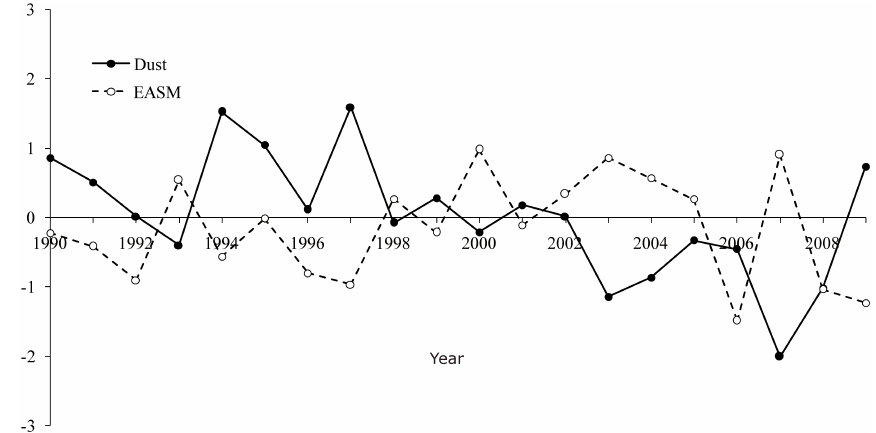
Figure 7. Difference of CON minus SEN in the normalized regional mean dust column load averaged over the Tibetan Plateau (27–39 ◦ N, 80–105 ◦ E) and in the EASM index for summer during the period 1990–2009 ( r = − 0 . 46).